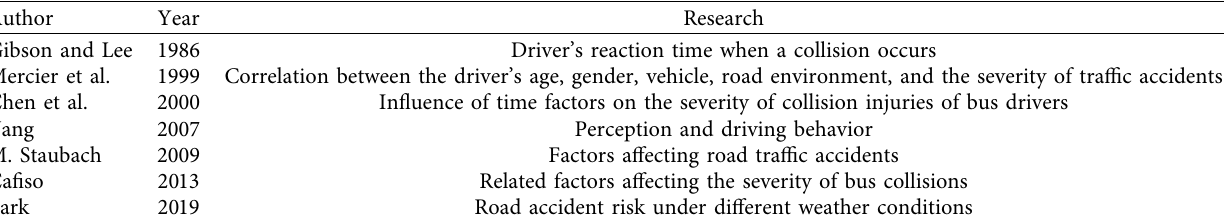
Table 1: Study of the relevant factors affecting the safe operation of